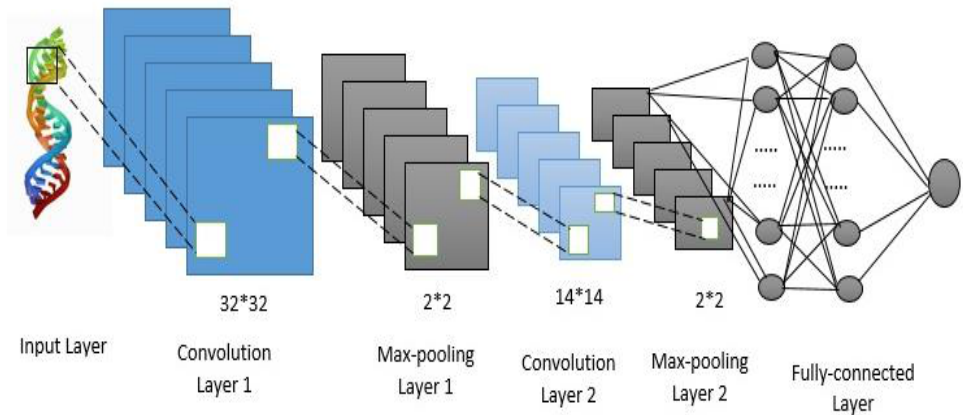
Figure 1. A Convolutional Neural Network (CNN) frame structure.